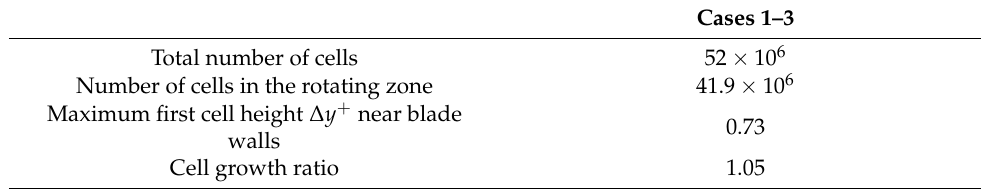
Figure 2. Important mesh regions: ( a ) Mesh refinement regions (dark grey) at the inlet gap and blades top region. Mesh cells near ( b ) the blade trailing edge and ( c ) the inlet gap. Table 2. The mesh parameters.